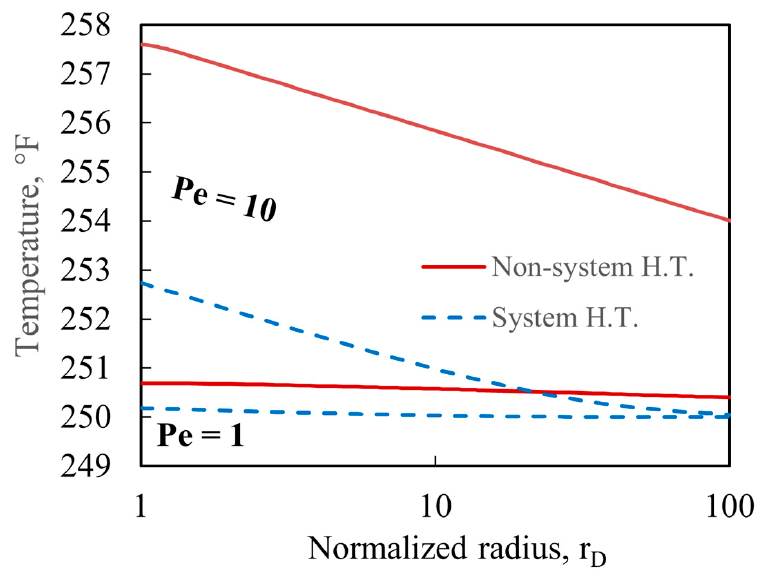
Figure 6. Comparison of radial temperature distribution with varying Peclet numbers.